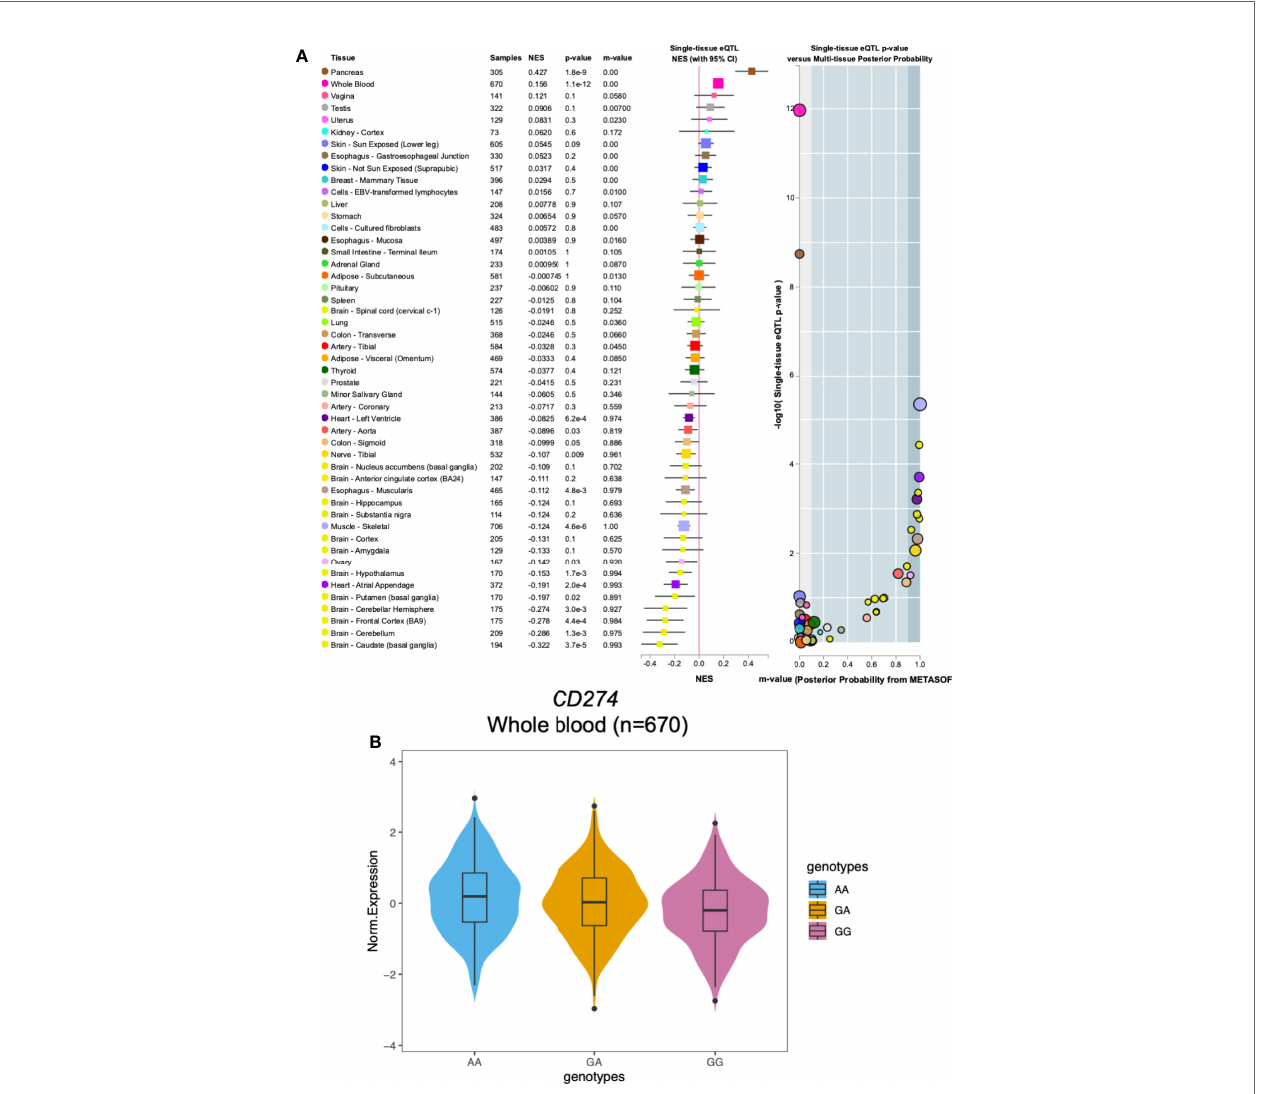
FIGURE 2 | The relationship between the CD274 : rs2297136 genotype with gene expression in Genotype-Tissue Expression (GTEx) dataset. (A) The association of CD274 : rs2297136 genotype with gene expression in multiple tissues in GTEx dataset. (B) The association of CD274 : rs2297136 genotype with gene expression in 670 whole blood samples in GTEx